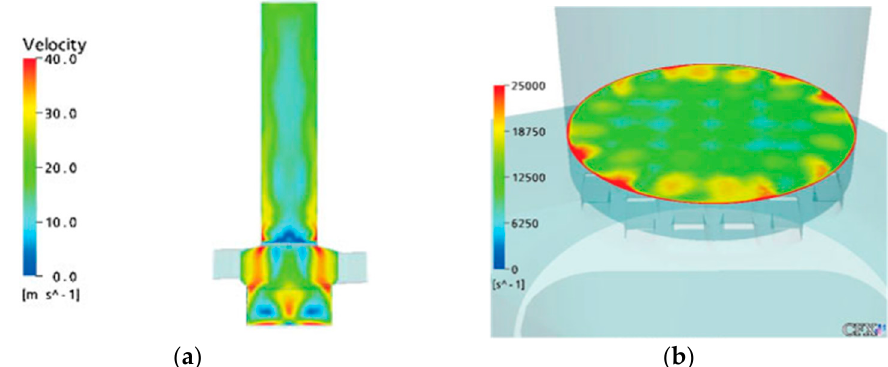
Figure 2. Calculated velocity profile ( a ) and turbulence scale ( b ) of an Aerolizer ® using RANS with k- ε SST model. Reproduced with permission from [8], Elsevier, 2004.